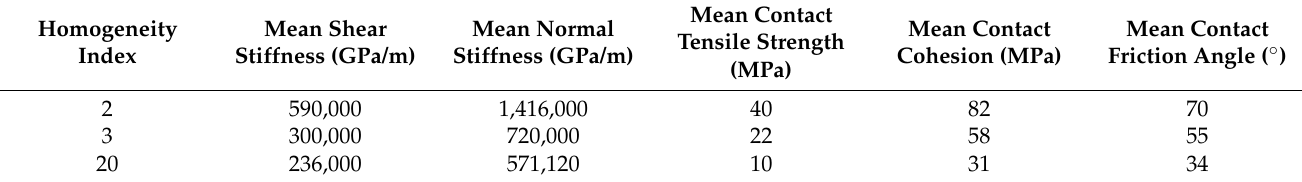
Table 2. Mean micro-properties of hydrostone samples in UDEC T-W model after calibration